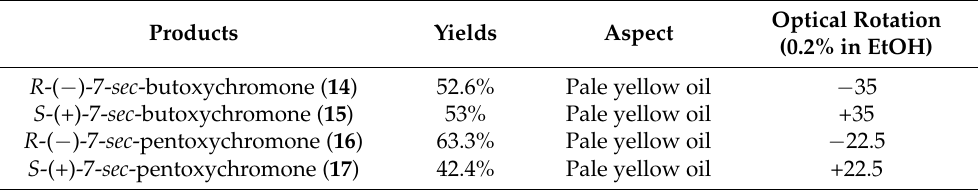
Table 15. Yields, aspect, and optical rotation of enatiomers compounds. Products Yields